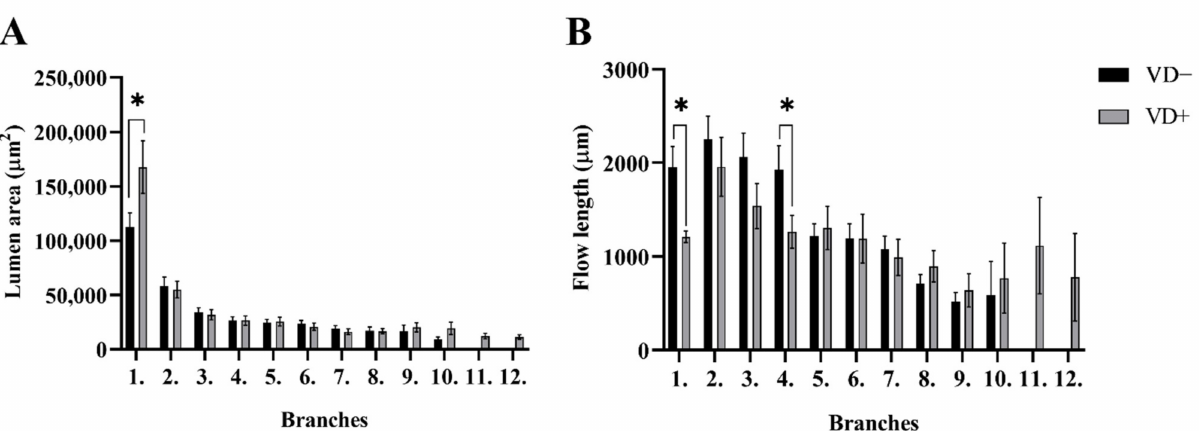
Figure 2. Segments analysis. ( A ) Lumen area of the segments from the VD − and VD+ animals. The lumen area of the first-order branches was significantly larger in VD+ group. ( B ) Flow lengths of the segments from the VD − and VD+ animals. The 1st- and 4th-order branches were lengthier in VD − rats. Values are means ± SEM. Two-tailed unpaired Student’s t -test and Mann–Whitney-test. * p < 0.05 VD − vs. VD+.